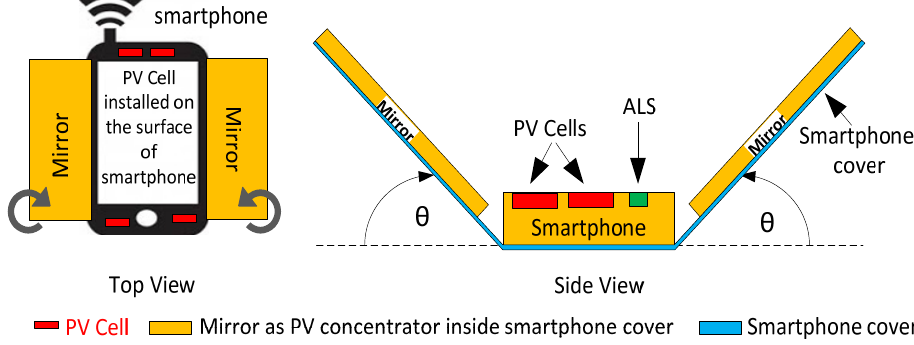
Figure 2. Using mirrors as solar concentrators to enhance the incident light on PV cells.